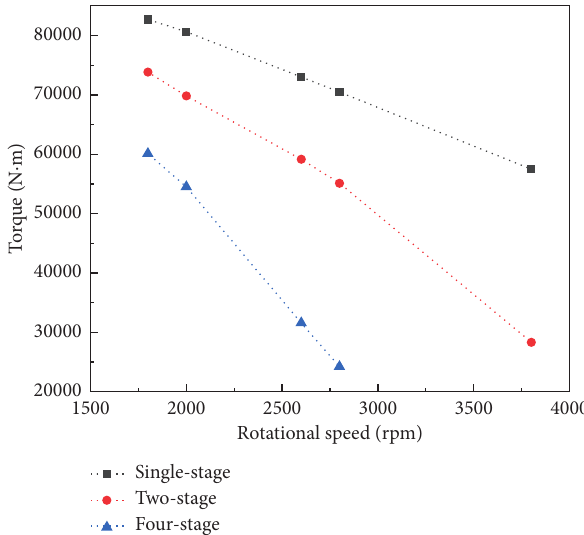
Figure 9: Relationship between output torque and rotational speed of large-size